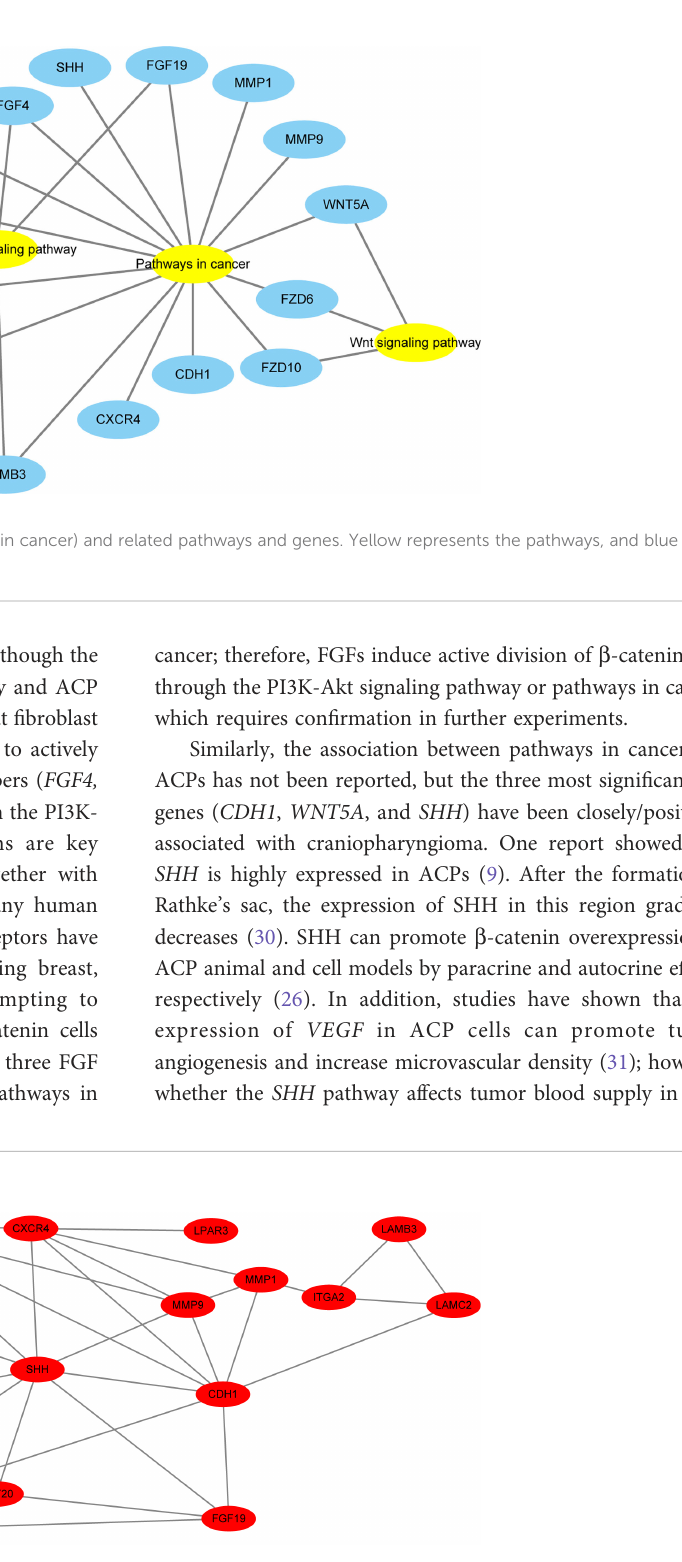
FIGURE 6 The interaction score was >0.7, and the PPI network of all upregulated DEGs (15 nodes and 33 edges) is shown.